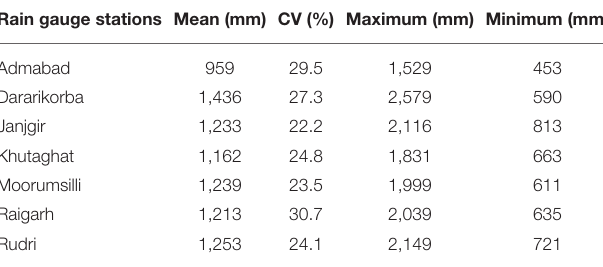
TABLE 1 | Analysis of point rainfall of seven locations in the study